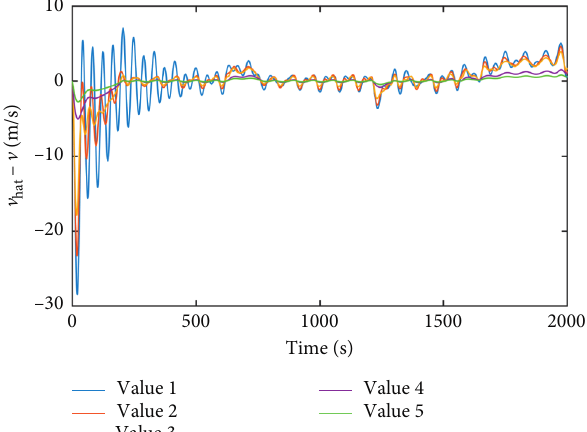
Figure 8: Position observer estimation error of the HST.